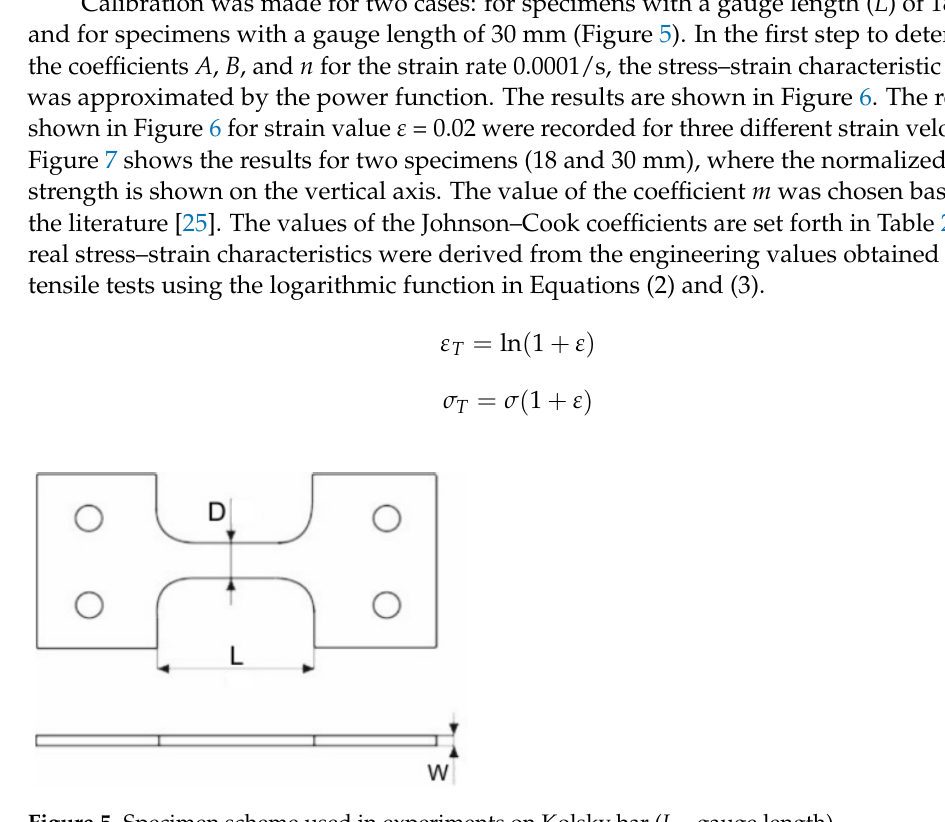
Figure 5. Specimen scheme used in experiments on Kolsky bar ( L —gauge length).